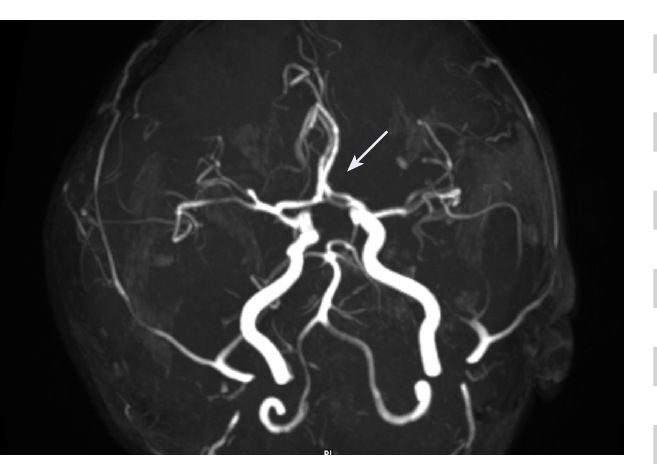
Figure 3: Duplicated Left A1 (Arrow).